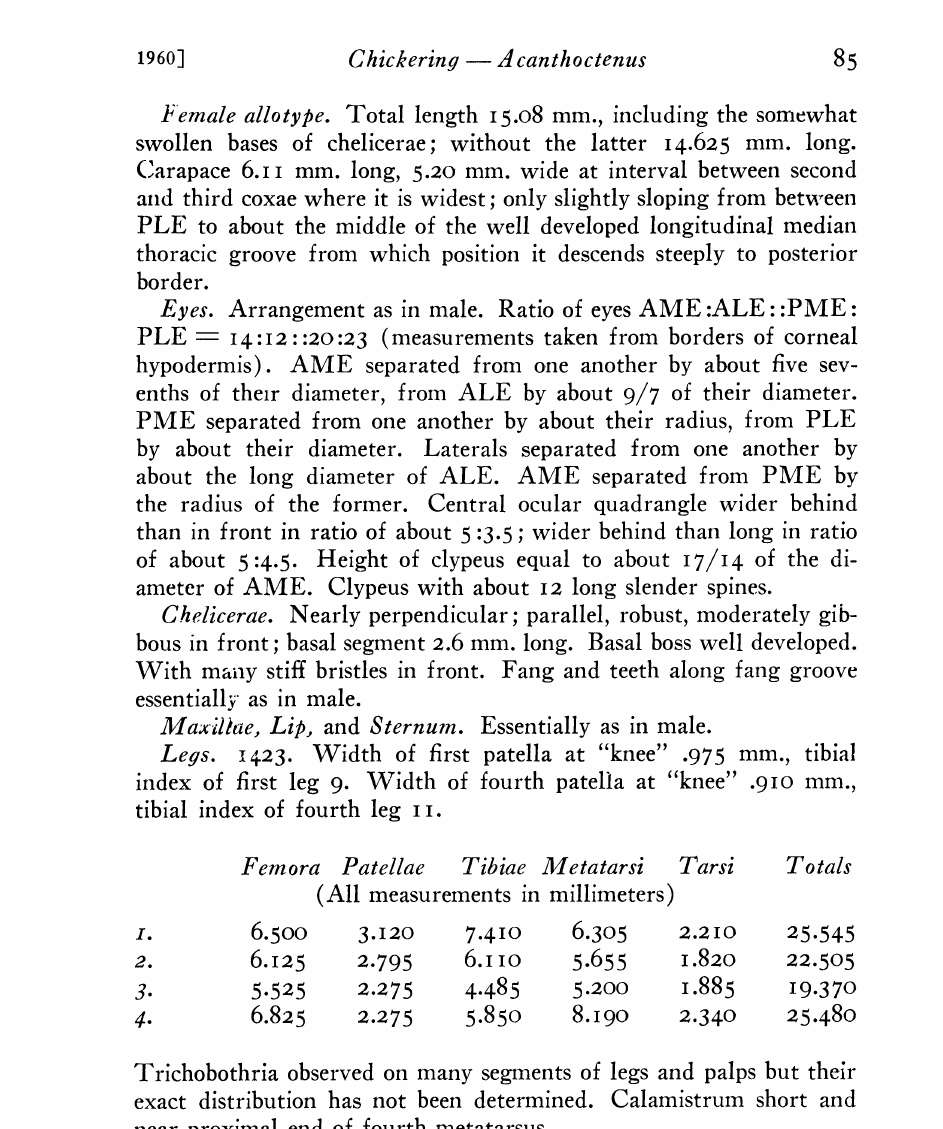
Trichobothria observed on many segments of legs and palps but their exact distribution has not been determined. Calamistrum short and near proximal end of fourth